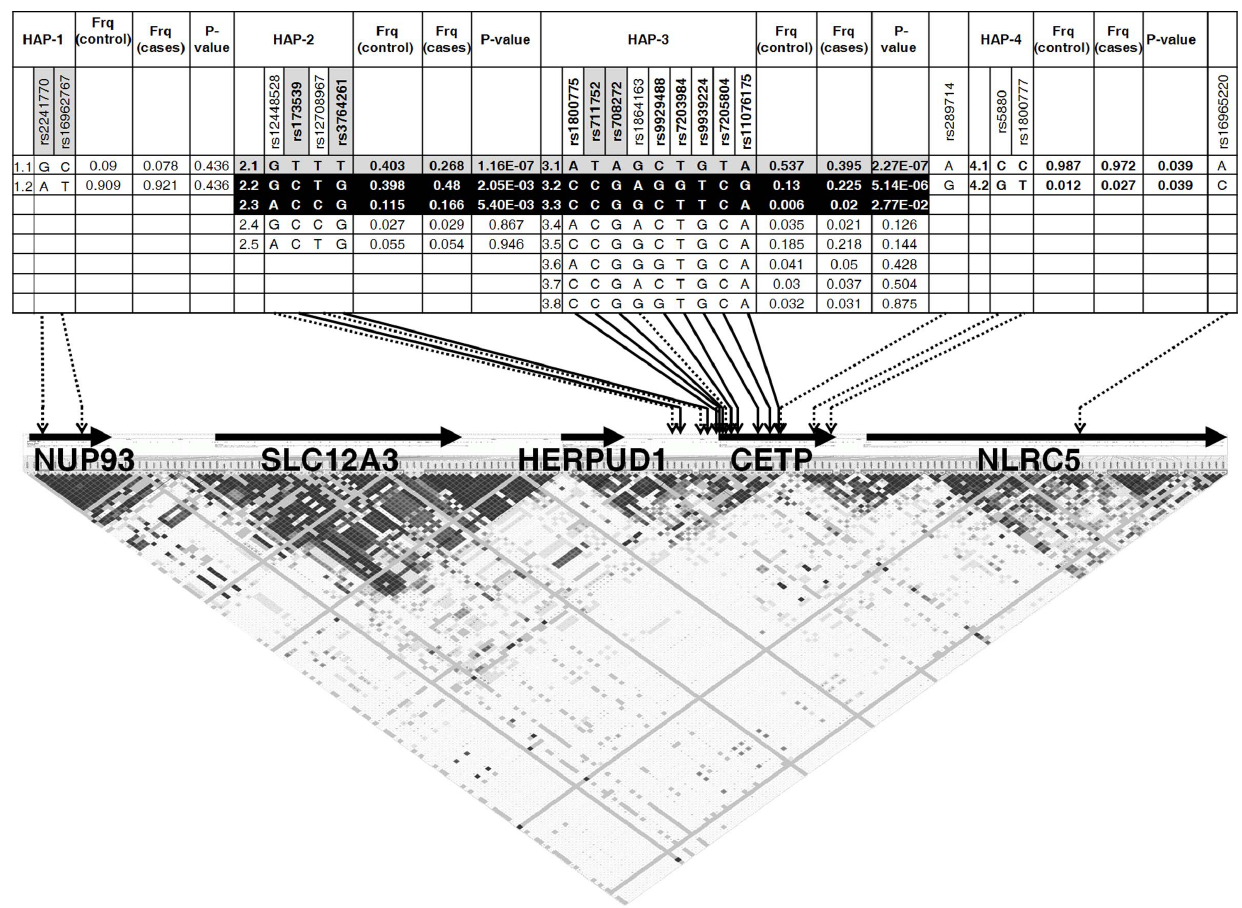
Figure 1. Location of genetic markers in CETP gene locus and haplotype association results. The upper part of the figure shows the haplotype association with low HDL-C levels. Haplotypes exceeding 1% frequency are shown. Frequency of each haplotype in cases and controls, and p-value from logistic regression is displayed. Significantly associated SNPs are in bold. Risk haplotypes are black filled, while protective haplotypes are grey filled. Lower part of the figure shows the schematic representation of CETP gene and pair wise LD plot. LD plot was calculated using HapMap data. Genes within the locus are indicated by thick, black horizontal arrows. Positions of the genotyped SNPs are displayed by arrows – filled arrows represent significantly associated SNPs and dotted arrows show positions of SNPs not associated with low